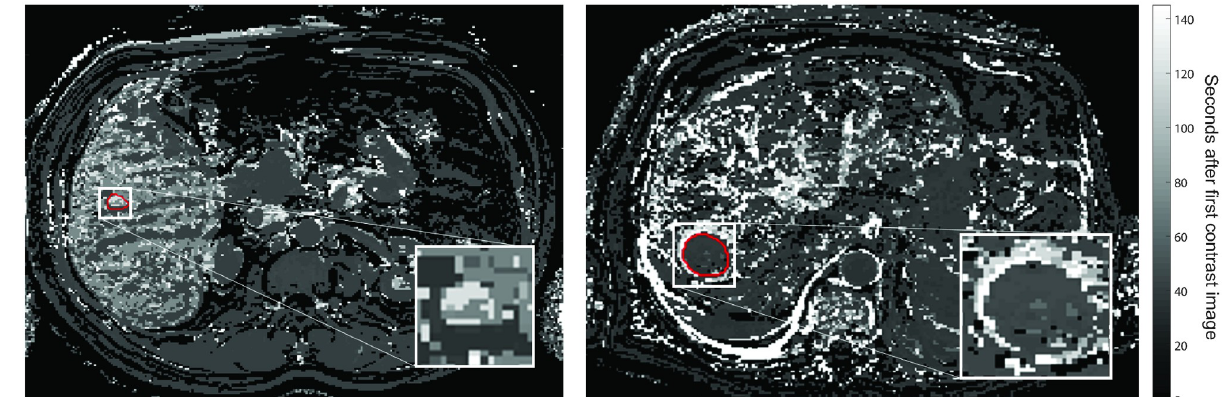
Fig 2. Time-to-peak feature maps of a liver with a hemangioma (left) and a HCC (right). The lesions correspond with the lesions in Fig 1. The red contours show the lesion segmentations.